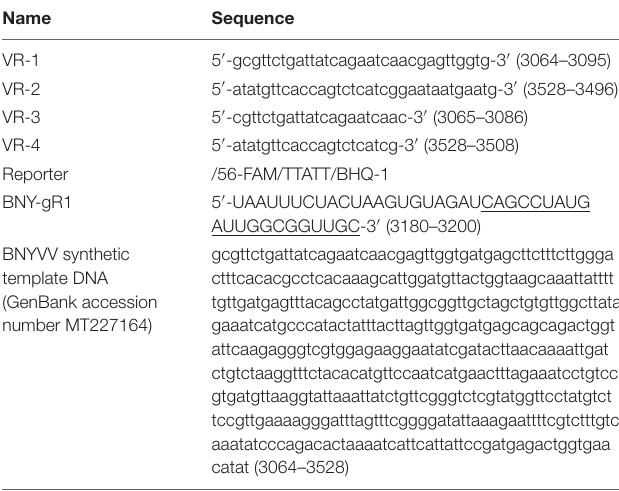
TABLE 1 | Sequences of primers, ssDNA reporter, CRISPR-guide RNA, and target used in this